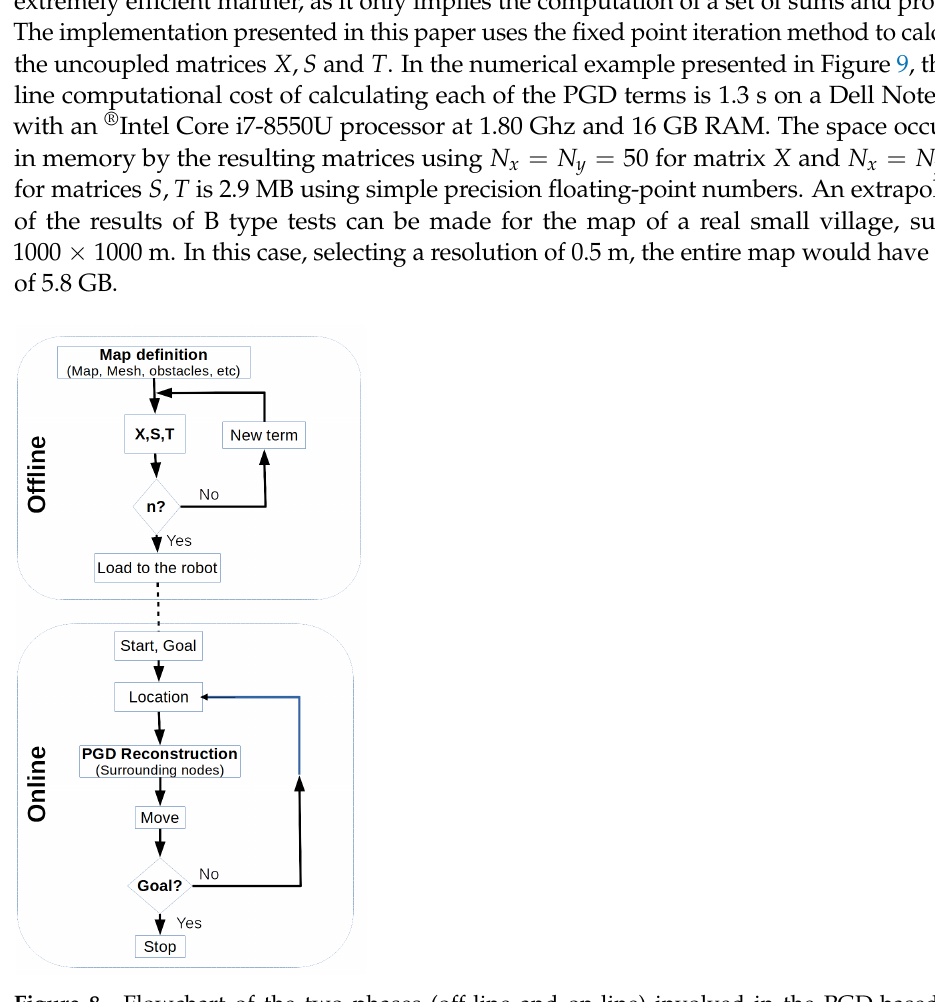
Figure 8. Flowchart of the two phases (off-line and on-line) involved in the PGD-based path planning method.